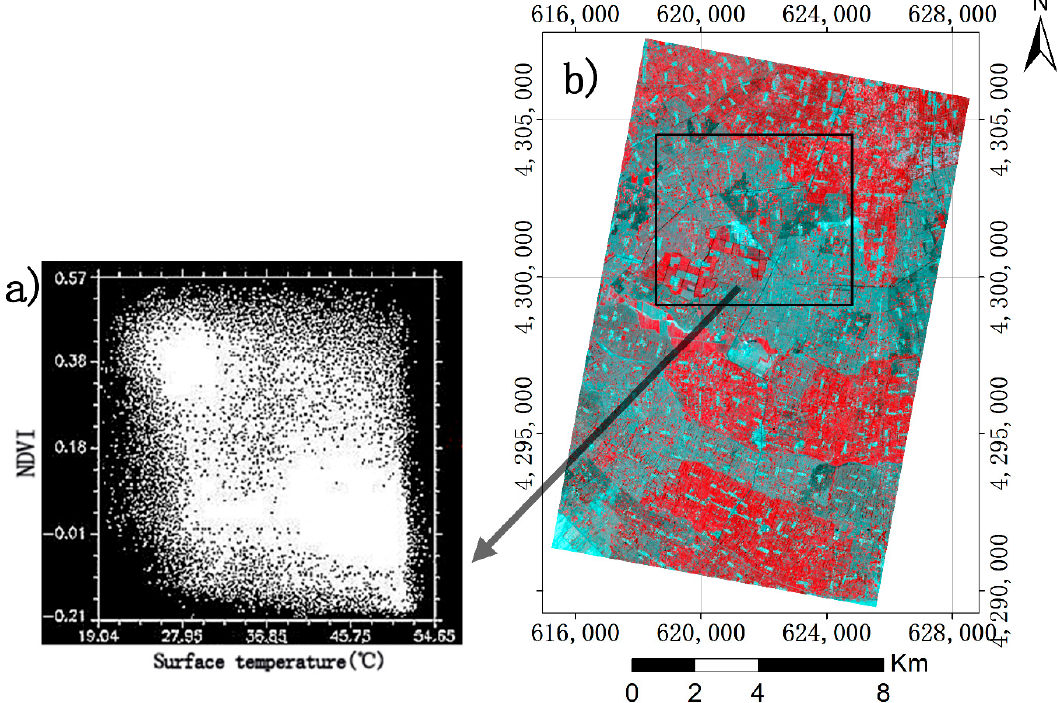
Figure 17. ( a ) The scatter plot of the normalized di ff erence vegetation index (NDVI) values against the land surface temperature (LST) values of a square area extracted from ( b ) the study area shown with an infrared color composite image.